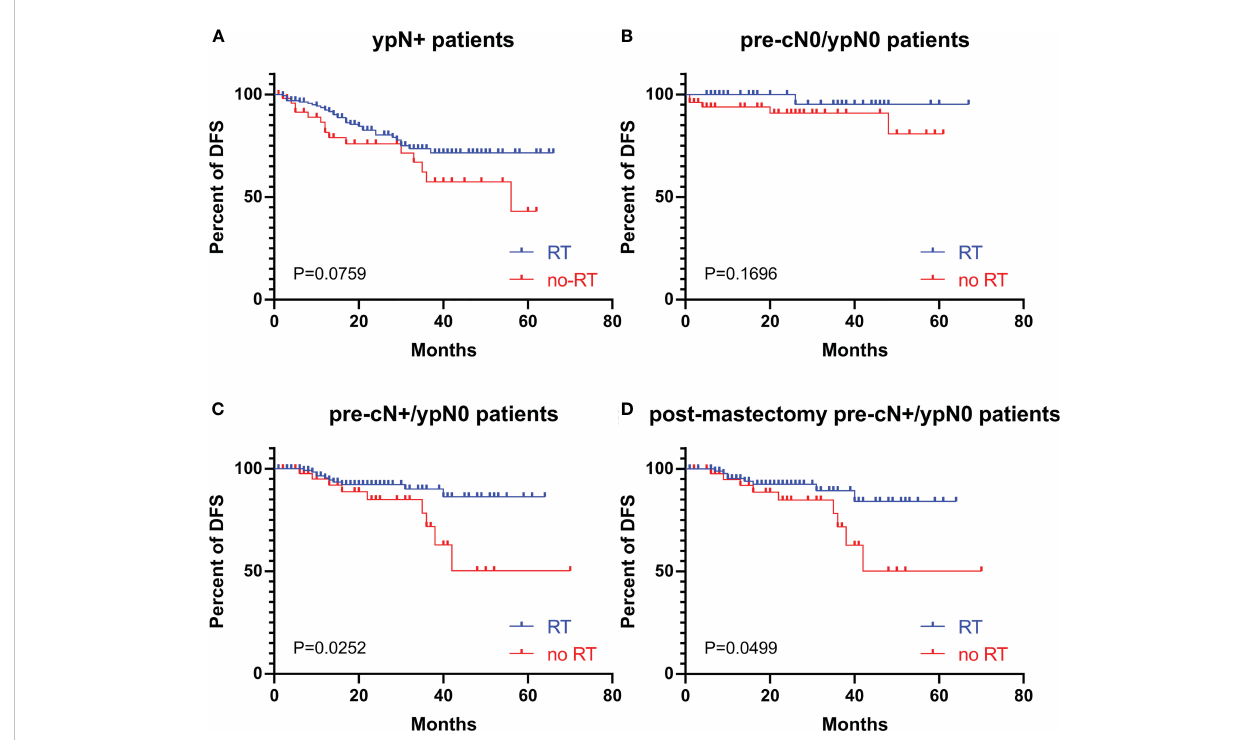
FIGURE 3 The DFS in patients with or without adjuvant RT with different pre-cN and ypN stages. (A) The association between adjuvant RT and DFS in ypN+ patients (n=217); (B) The association between adjuvant RT and DFS in pre-cN0/ypN0 patients (n=92); (C) The association between adjuvant RT and DFS in pre-cN+/ypN0 patients (n=177); (D) The association between adjuvant RT and DFS in post-mastectomy pre-cN+/ypN0 patients (n=142). RT, radiation